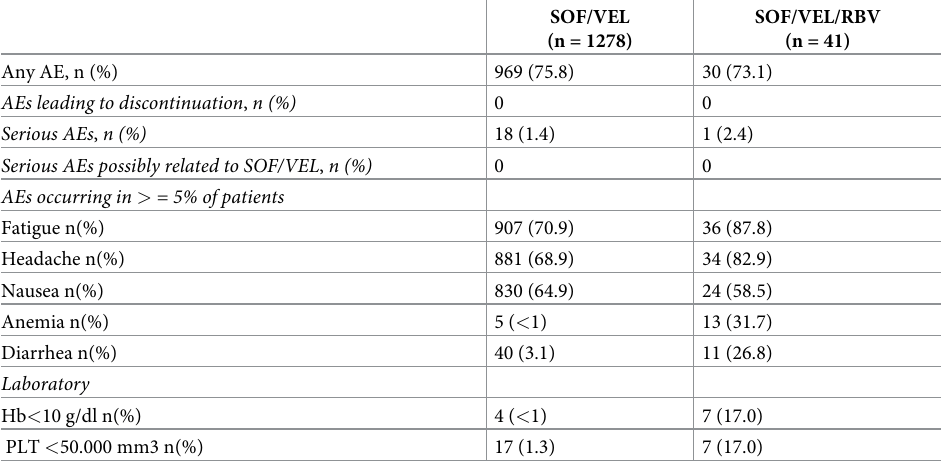
Table 5. AE in patients treated with SOF/VEL or with